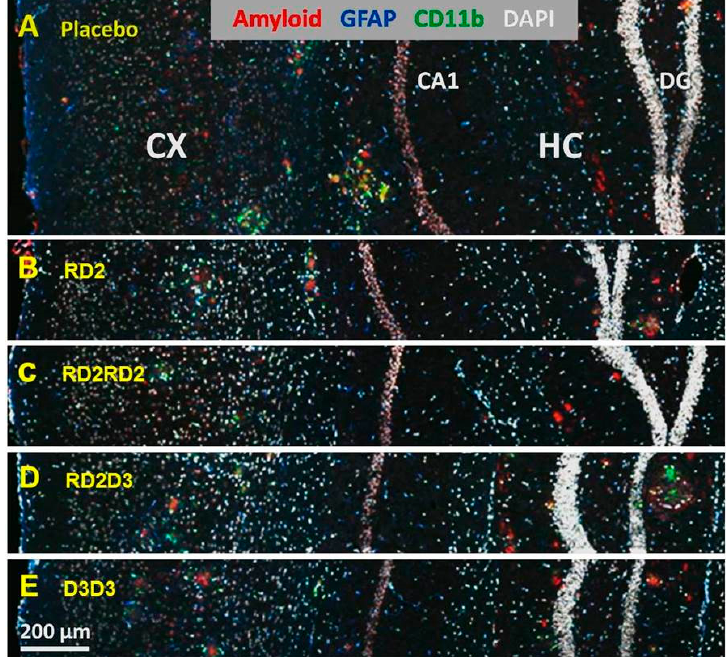
Figure 3. Immunofluorescent labeling of amyloid and glia cells. The images show exemplary immunofluorescent labeling of amyloid (antibody 6E10, red), astrocytes (GFAP (glial fibrillary acidic protein), blue), and activated microglia (CD11b, green) in mice of all groups ( A – E ). Nuclei are labeled with DAPI (white) to provide the requested comparison between the different groups. Abbreviations: CX, Cortex; CA1, cornu Ammonis area 1; HC, hippocampus; DG, dentate gyrus.